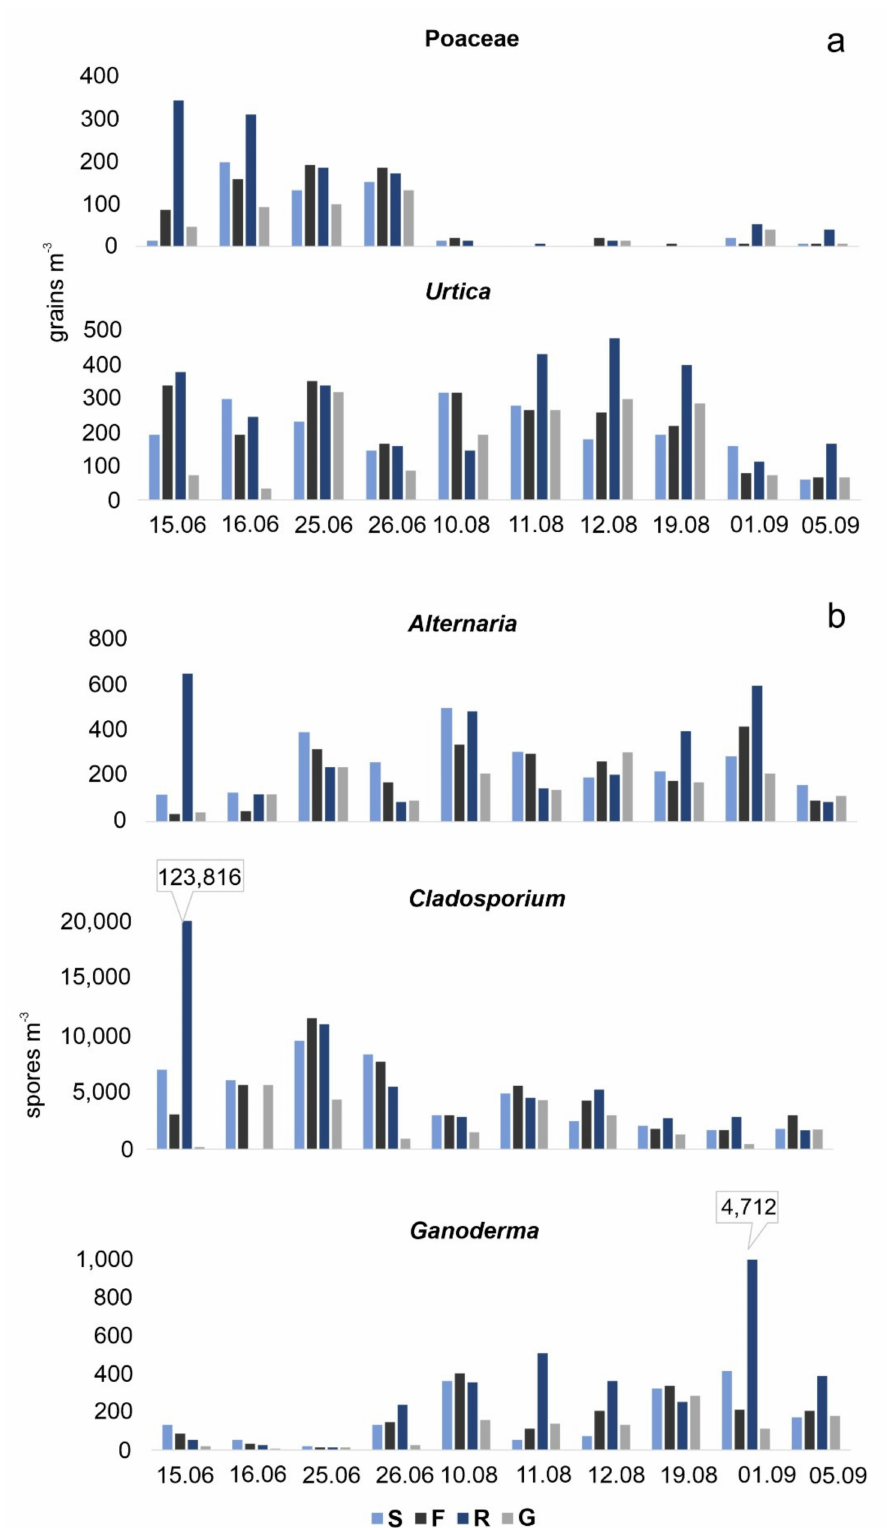
Figure 9. ( a ) Number of Poaceae and Urtica pollen grains in 1 m 3 of the air in the study sites; ( b ) Number of Alternaria, Cladosporium , and Ganoderma fungal spores in 1 m 3 of the air in the study sites (S—open swimming pools, F—multi-media fountain, R—reservoir, G—gravel pit